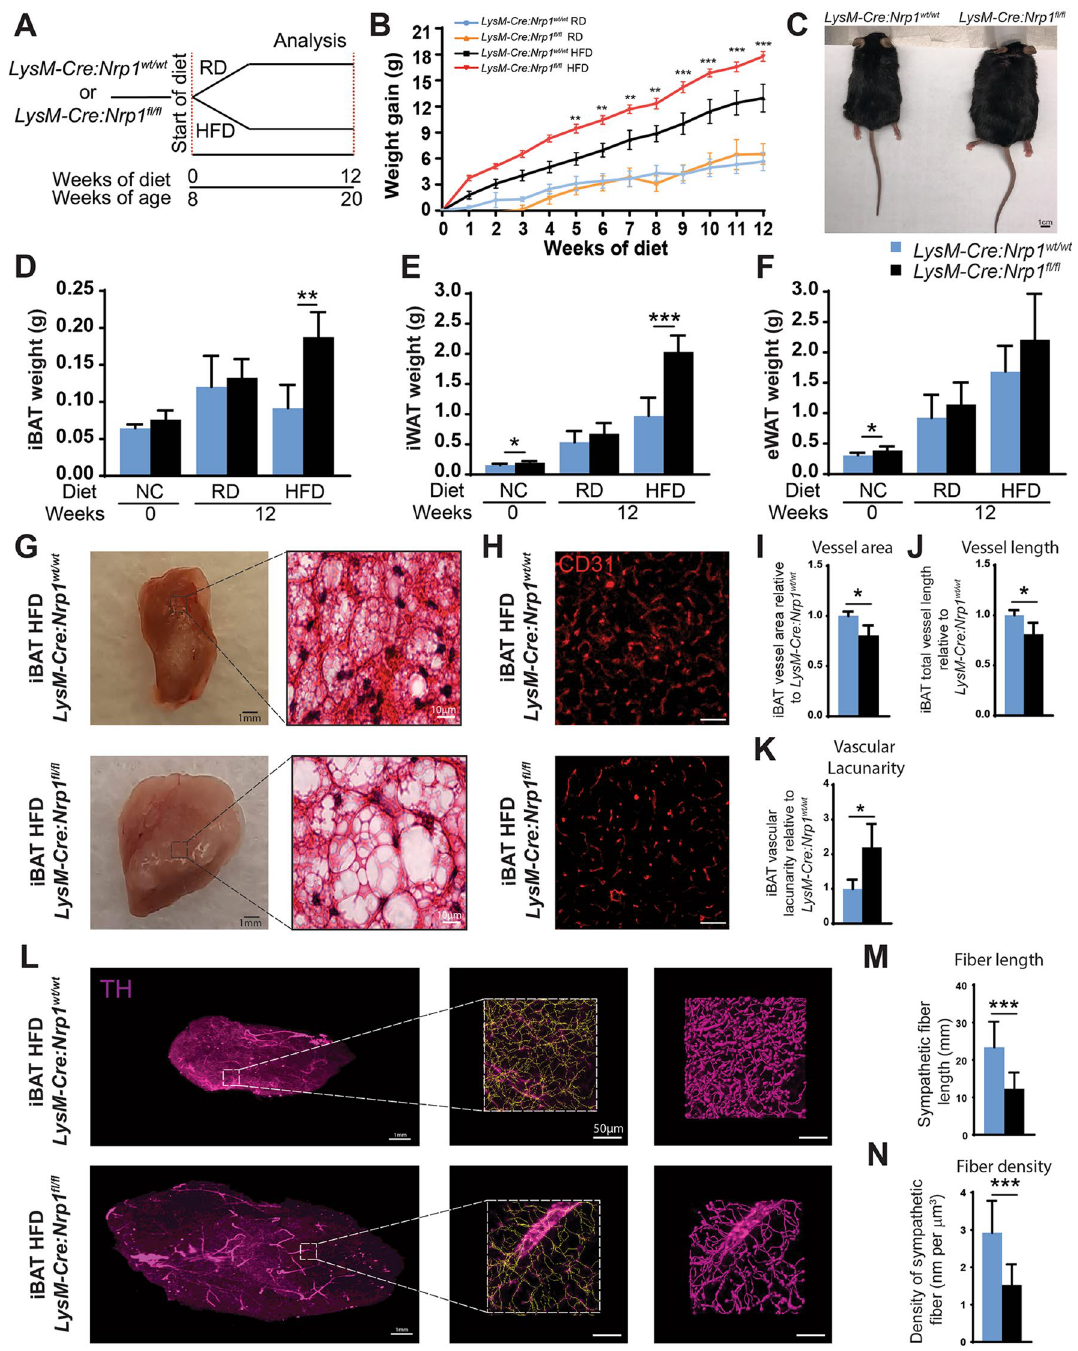
Figure 2. Neuropilin-1-expressing myeloid cells influence interscapular brown adipose tissue composition in diet- induced obesity. ( A ) Schematic representation of the experimental design. At 8 weeks of age, mice were fed with a high-fat diet (HFD) or a matched regular diet (RD) up to 12 weeks. ( B ) Weight gain of LysM-Cre:Nrp1 fl/fl , LysM- Cre:Nrp1 wt/wt mice on RD or HFD for 12 weeks (n = 4–9). ( C ) Representative photographs of LysM-Cre:Nrp1 wt/wt and LysM-Cre:Nrp1 fl/fl mice undergoing HFD. ( D ) iBAT, ( E ) iWAT and ( F ) eWAT masses at different time-points after RD or HFD diet feeding (n = 4–6). ( G ) Representative images of fat pads and their corresponding H&E staining of iBAT from LysM-Cre:Nrp1 wt/wt and LysM-Cre:Nrp1 fl/fl mice fed a high fat diet after 12 weeks of diet, n = 4 mice per genotype. ( H ) Representative images of iBAT from LysM-Cre:Nrp1 wt/wt and LysM-Cre:Nrp1 fl/fl mice stained with CD31, imaged on confocal microscope at 10× magnification; scale bar 50 µm. ( I – K ) Quantification of vessel area ( I ) length ( J ) and lacunarity ( K ) per section normalized to LysM-Cre:Nrp1 wt/wt (n = 5 per group). ( L ) Representative top view of 3D reconstructions of iBAT from LysM-Cre:Nrp1 wt/wt and LysM-Cre:Nrp1 fl/fl mice stained with TH, imaged on light sheet microscope at 4 × magnification, using the automatic filament tracing tool in Imaris; TH signal is shown in magenta and reconstructed fibers in yellow. ( M – N ) Density of sympathetic fiber length ( M ) and density of sympathetic fiber ( N ) from 12-week HFD-fed LysM-Cre:Nrp1 wt/wt and LysM-Cre:Nrp1 fl/fl mice housed at room temperature. Data are presented as mean ± SEM. * p < 0.05, ** p < 0.01; *** p <